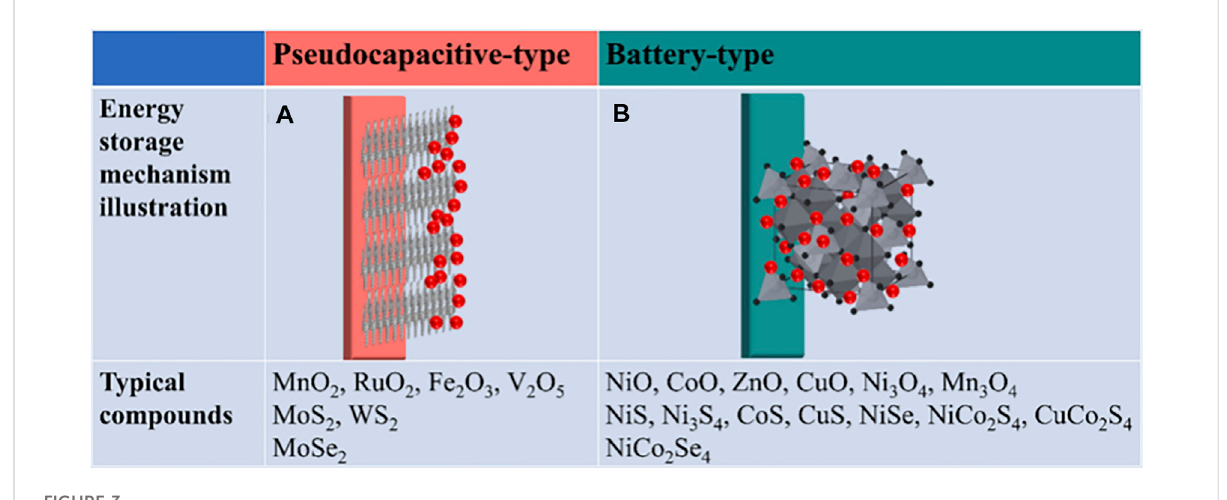
FIGURE 3 Energy storage mechanism demonstration and typical compounds: (A) pseudocapacitive-type materials and (B) battery-type materials (Zhu